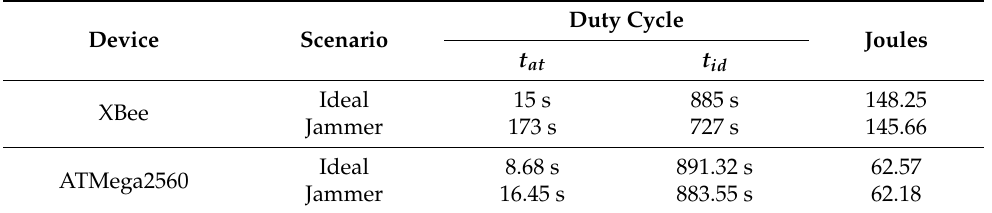
Table 5. The duty cycle and the energy consumption in Joules is calculated for each device that gener- ates the transmission of the packets for the scenarios in the presence and in absence of the